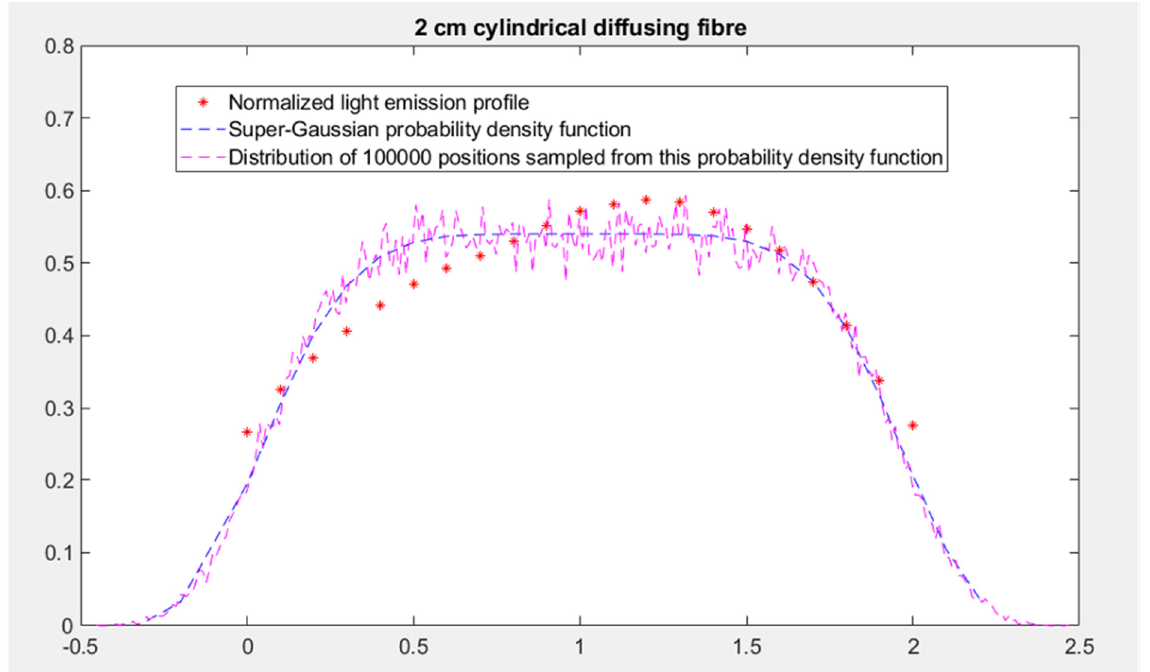
Figure 3. The light emission profile of the 2 cm cylindrical diffusing fiber (represented by red dots), the associated super- Gaussian probability density function (represented by blue dashes) and the distribution of 100,000 positions sampled from this probability density function (represented by magenta dashes).